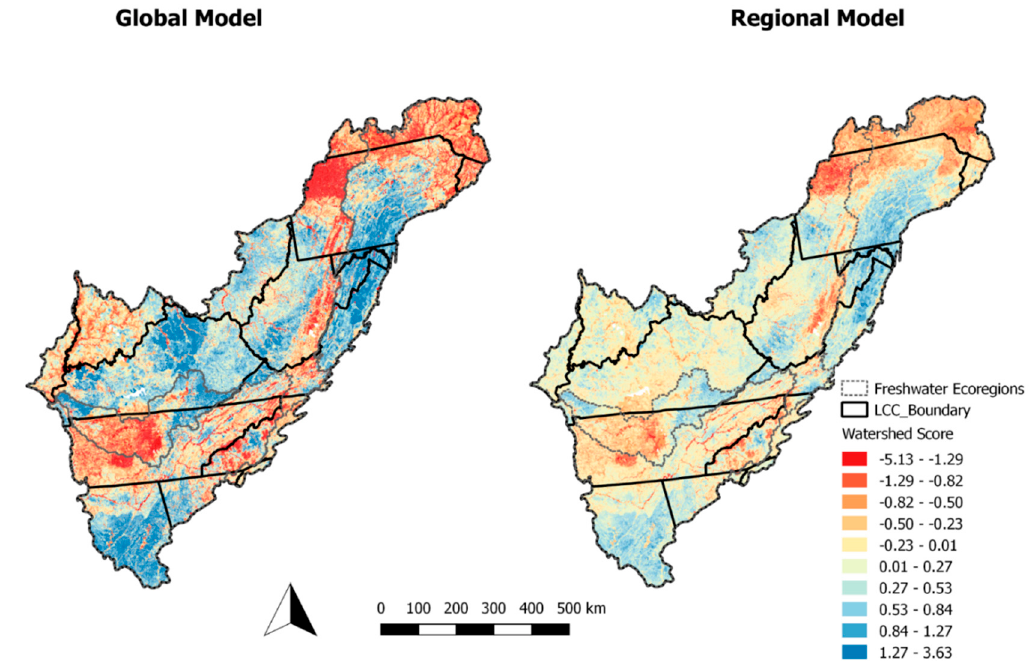
Figure 3. Comparison of the watershed score for the global and regional models. The watershed scores were centered and scaled. The regional watershed scores were centered and scaled within each respective region within the Appalachian Landscape Conservation Cooperative (LCC) region. The global watershed scores were centered and scaled across the entire Appalachian LCC region. Map created by R. Daniel Hanks using ArcGIS v10.3 [22].